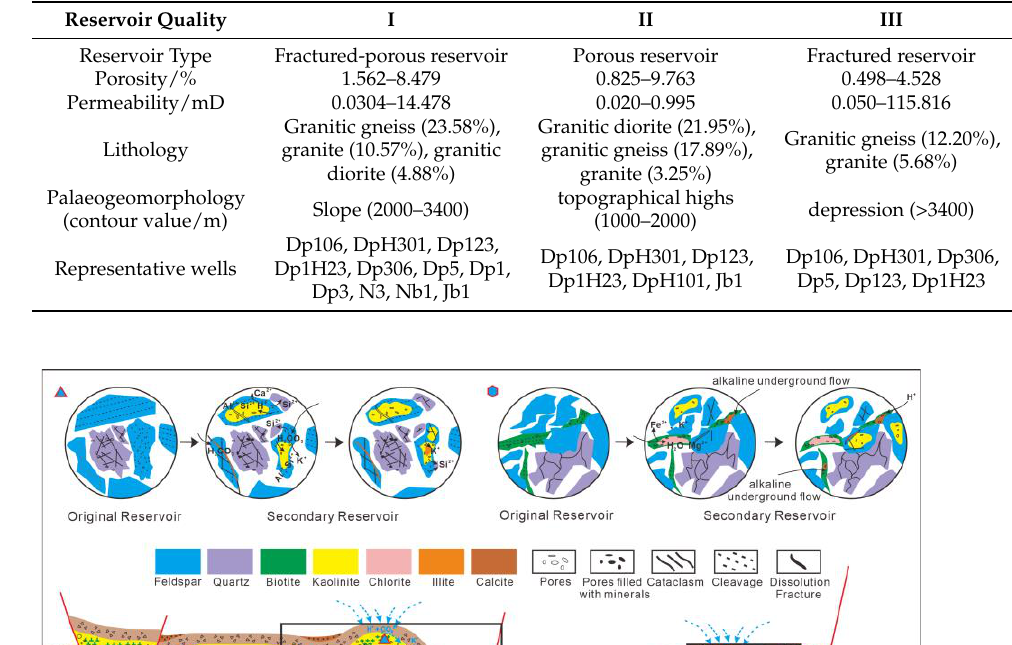
Table 4. Appraisal parameters of the granitoid reservoirs in Qaidam Basin.